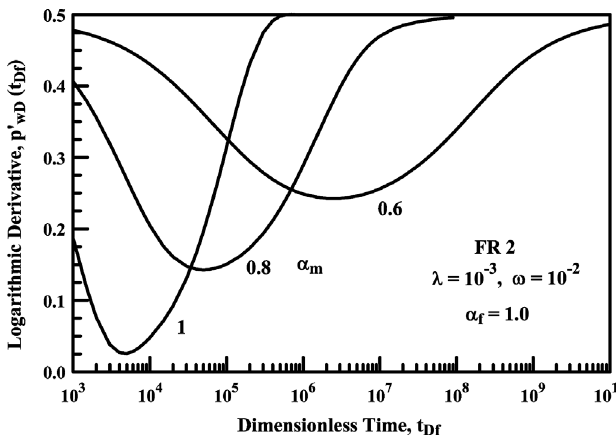
Figure 4. Derivative responses illustrating interactions between a f and a m . The intent is to demonstrate the in fl uence on well responses as a f ? a m . The circles denote Flow Regime 2 and the squares represent Flow Regime 3.